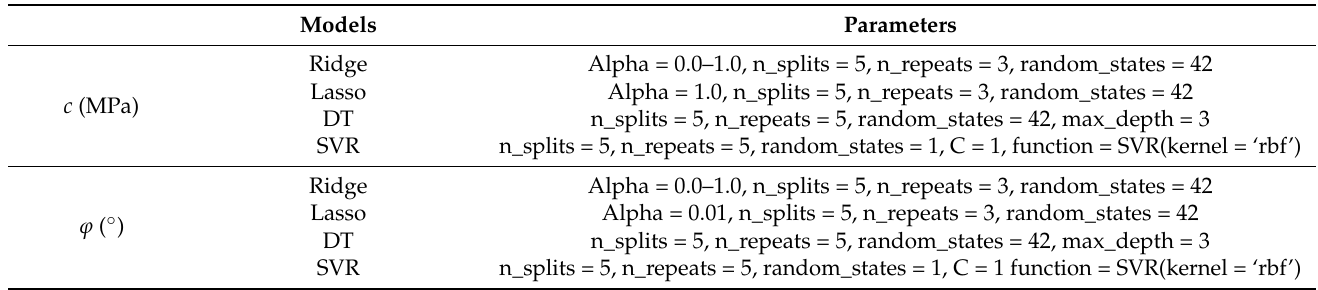
Table 2. Optimized